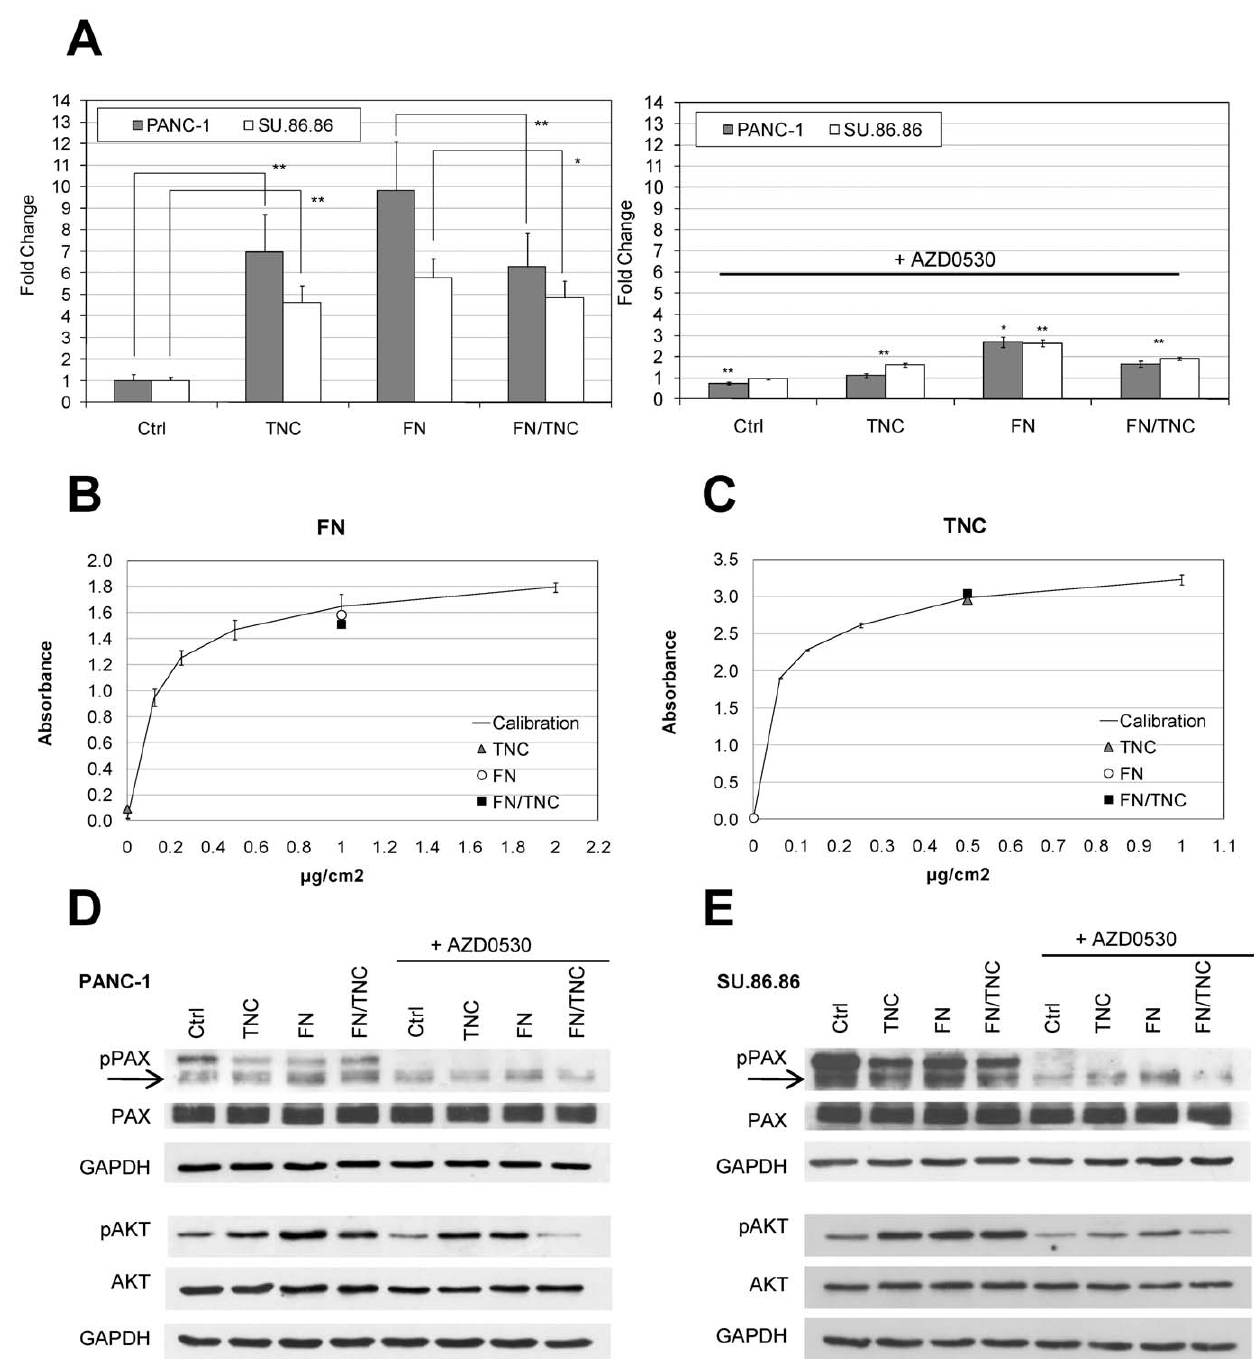
Figure 4. Effect of TNC, FN, and FN/TNC coating on the adhesion of PANC-1 and SU.86.86 cell lines. (A) Cells were plated in medium containing 1% FBS, incubated for 3 hours and fixed. For pharmacological inhibition, cells were incubated with AZD0530 2 m M for 15 min before plating. Left panel: TNC enhances cell adhesion compared to uncoated plates and decreases cell attachment to FN. Right panel: When treated with AZD0530, cells displayed a reduced adhesion compared to the non treated cells at all conditions tested. Data are calculated as mean + / 2 s.e.m of two experiments and expressed as fold-change compared to the control (Ctrl) (left panel) or to the untreated cells (right panel) (*p , 0.01, **p , 0.001, ANOVA test). (B, C) 96-well plates were coated with TNC (0.5 m g/cm 2 ), FN (1 m g/cm 2 ) or both proteins simultaneously (FN/TNC) and ELISA was performed as described in Methods. The substrate binding activity of TNC or FN is not affected when both proteins areused to coat the plastic surface. (D, E) PANC-1 (D) and SU.86.86 cells (E) were plated for 45 min before total protein extraction was performed. Phosphorylation of paxillin at Tyr 118 (pPAX) and of Akt at Ser 473 (pAKT), and total paxillin and Akt expression levels were investigated by immunoblotting using specific antibodies and after treating the cells with the Src kinase inhibitor AZD0530. GAPDH detection was used to confirm equal protein loading.